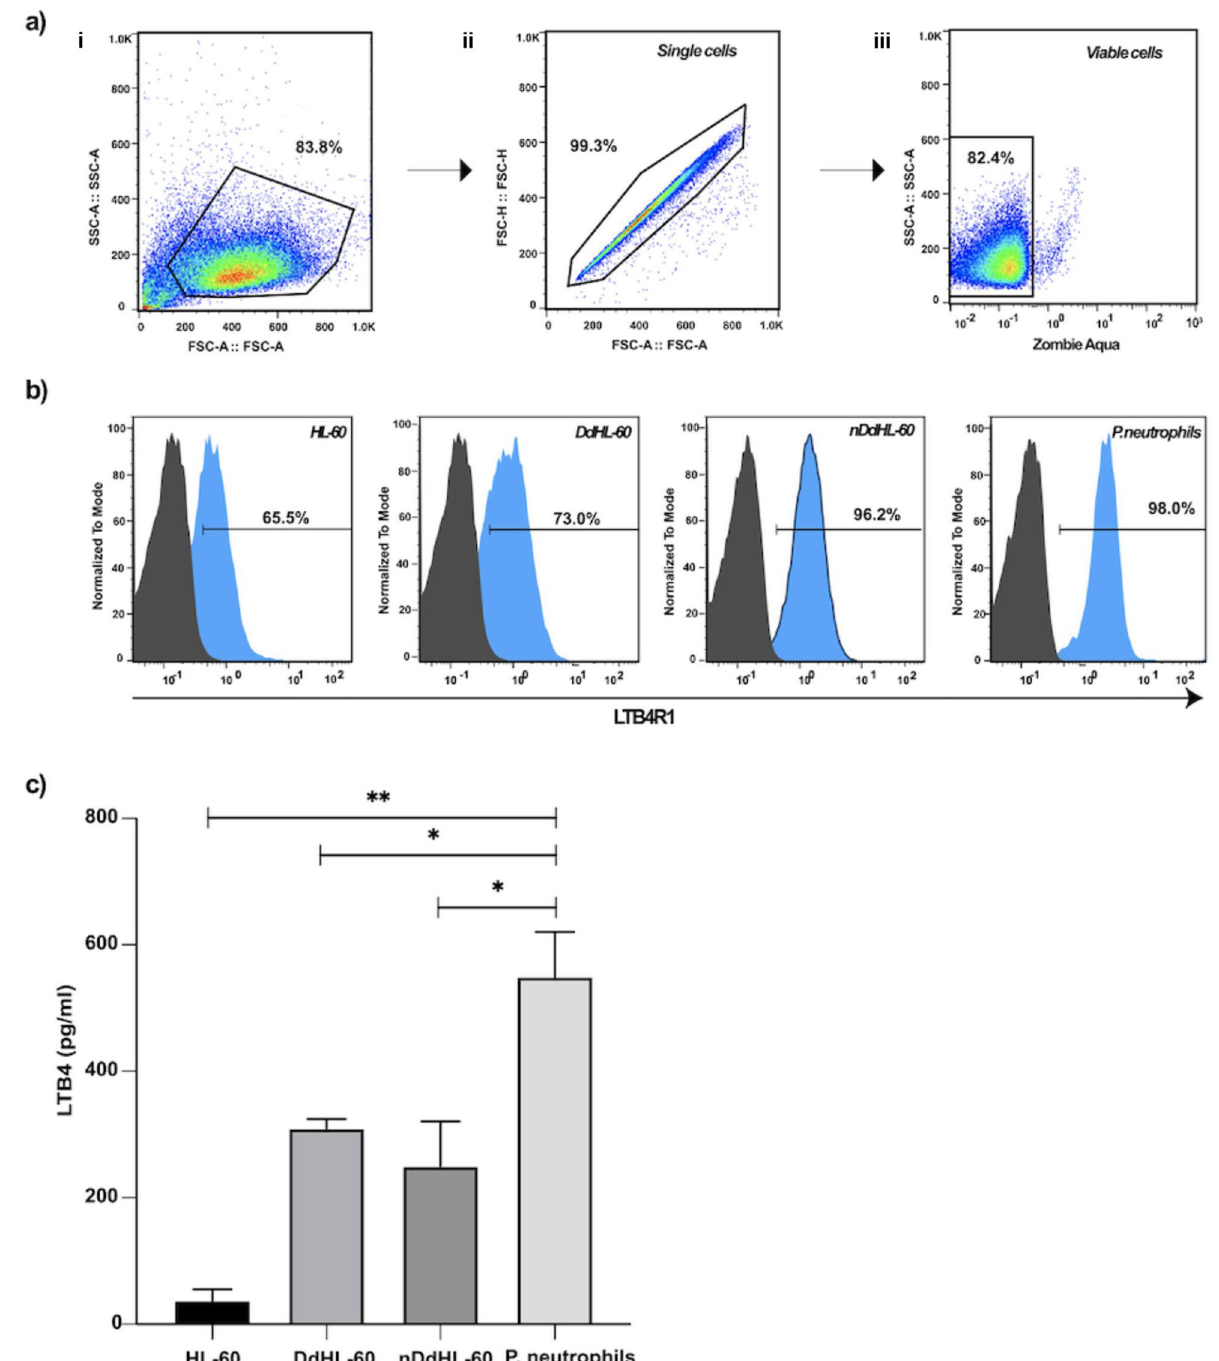
Figure 7. Quantification of LTB4 receptor and release in dHL-60 cells and primary neutrophils. ( a ) Flow cytometry image showing gating strategy of cells based on FSC/SSC profile, subsequently selecting single and viable cells. ( b ) Flow cytometry analysis of expression of LTB4-R1 on gated cells as in ( a ) for undifferentiated HL-60 cells, DdHL-60 cells, nDdHL-60 cells and Primary neutrophils (Black curves: LTB4-R1 negative cells, Blue curves: LTB4-R1 positive cells. Horizontal bars show percentage of LTB4-R1 positive cells), ( c ) HL-60 cells, DdHL-60 cells, nDdHL-60 cells and Primary neutrophils were incubated with Salmonella typhimurium for 4 h, and the amount of LTB4 in the supernatant was determined by ELISA (Error bars: mean ± SD; n = 3 experiments). Comparison were performed by unpaired, two-tailed t-test; ** P < 0.01, * P <